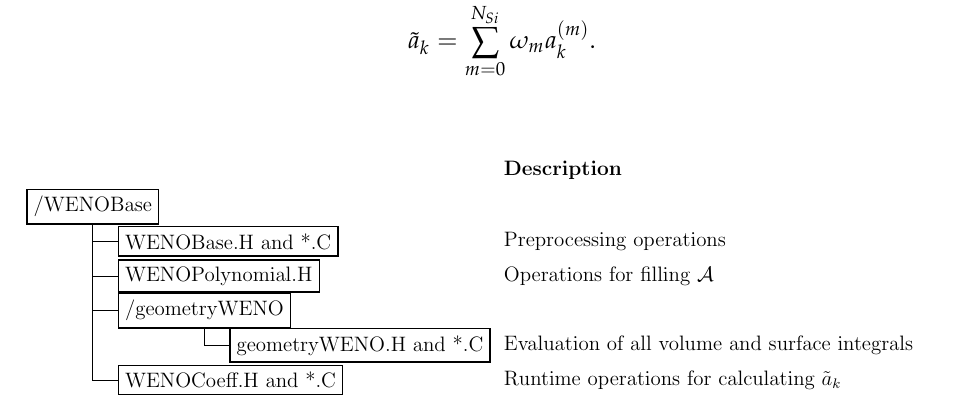
Figure 4. File structure of the WENO reconstruction